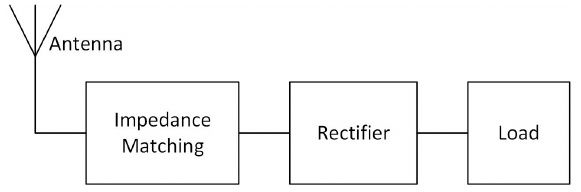
Figure 1. Block diagram of a rectenna with an output load.